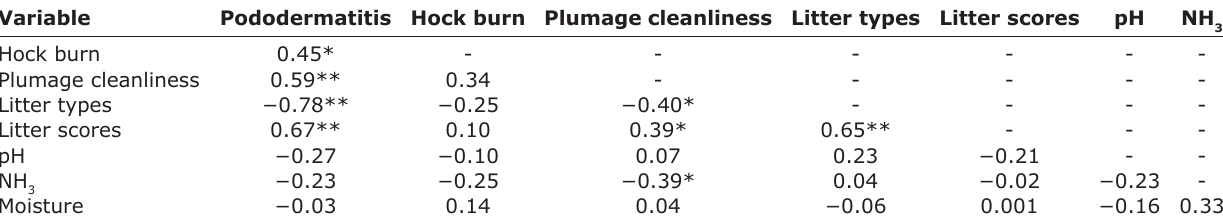
Table-5: Spearman correlation between welfare indicators and physicochemical characteristics of litter.